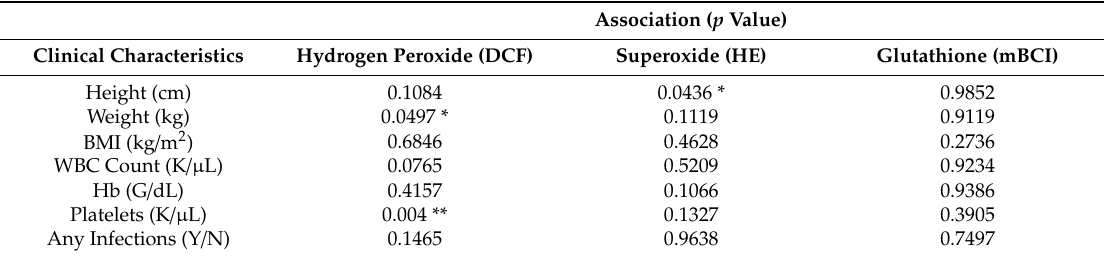
Table 6. Multi-level regression model examining the relationships between oxidative stress measures a and clinical